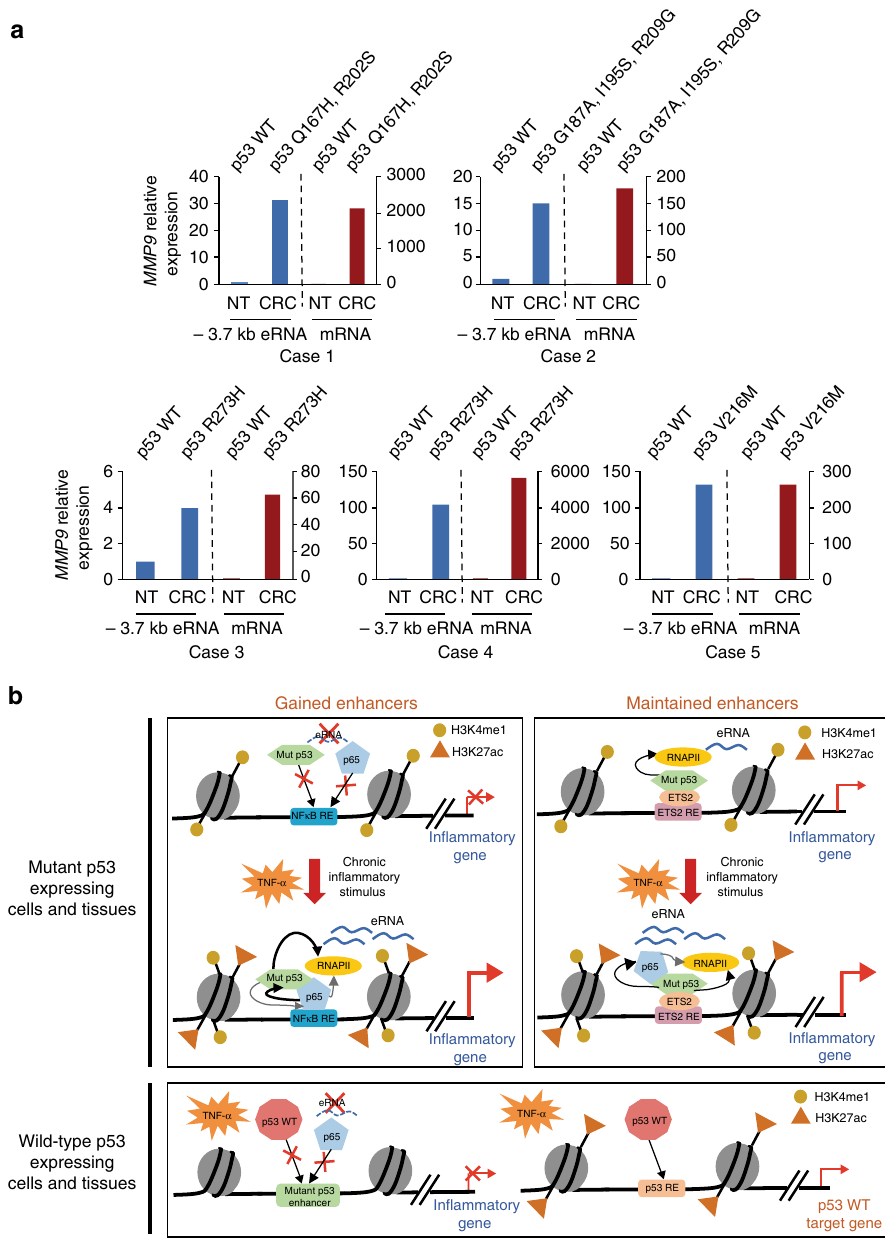
Fig. 6 Mutp53 enhancer and gene activation in human colon tissues. a qRT-PCR analysis of MMP9 eRNA from the − 3.7 kb enhancer and mRNA expression levels from fi ve independent cases of paired non-neoplastic (NT) and colorectal carcinomas (CRC) expressing wild-type and mutant forms of p53, respectively. mRNA expression levels of NT and CRC samples were normalized to β -actin levels. The expression levels shown for each CRC sample is relative to the expression levels of its corresponding NT sample. b Proposed model in which mutp53 through interactions with NF κ B directs enhanced RNAPII recruitment that is required for the potent induction of enhancer transcription and pro-tumorigenic gene expression in response to chronic TNF signaling. The contributions of wild-type p53 were also examined in this study and are included in our model to show that the TNF- α -induced changes in gene expression are mutp53-dependent as wild-type p53 is neither recruited to the mutp53-bound enhancer regions, nor regulates enhancer activation